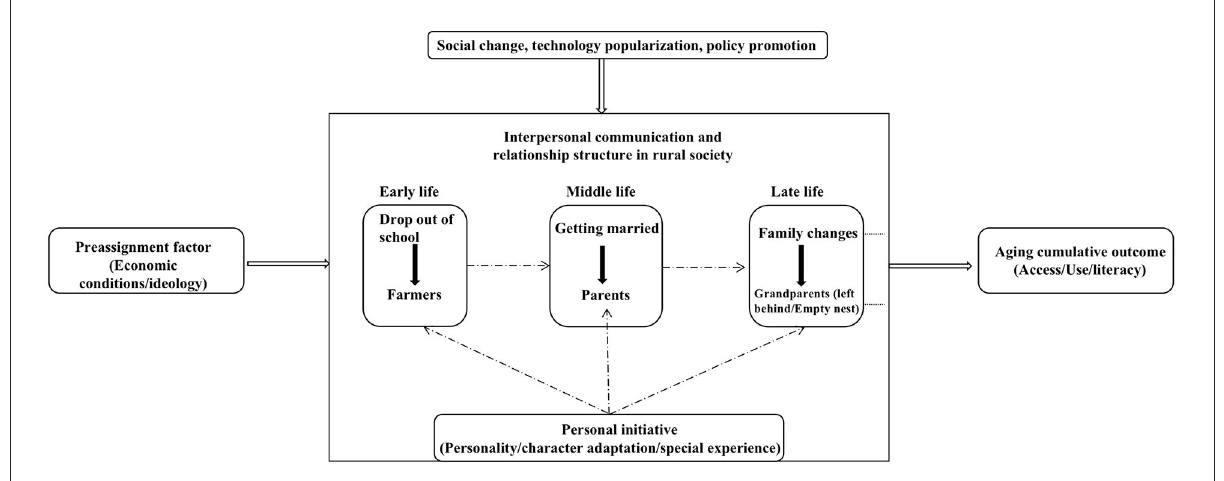
FIGURE2 Association between life course and digital inclusion outcomes of rural